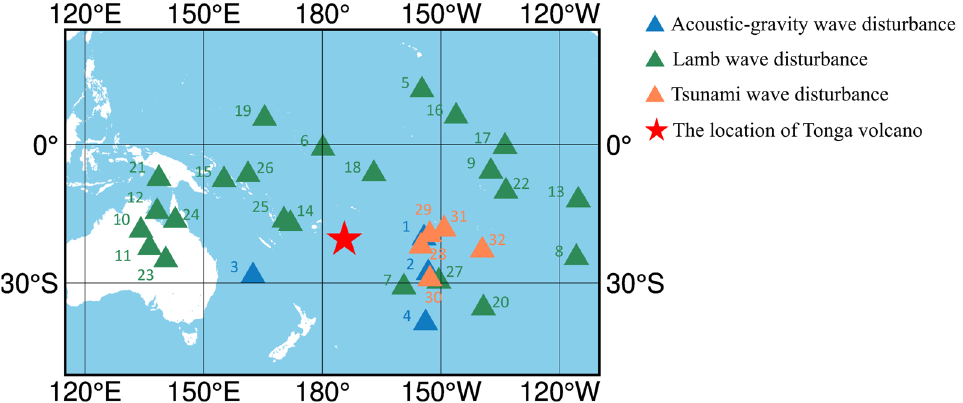
Figure 2. Distribution of 32 electron density profiles with significant disturbance anomalies within 6500 km of the volcanic eruption within 6 h of the eruption.